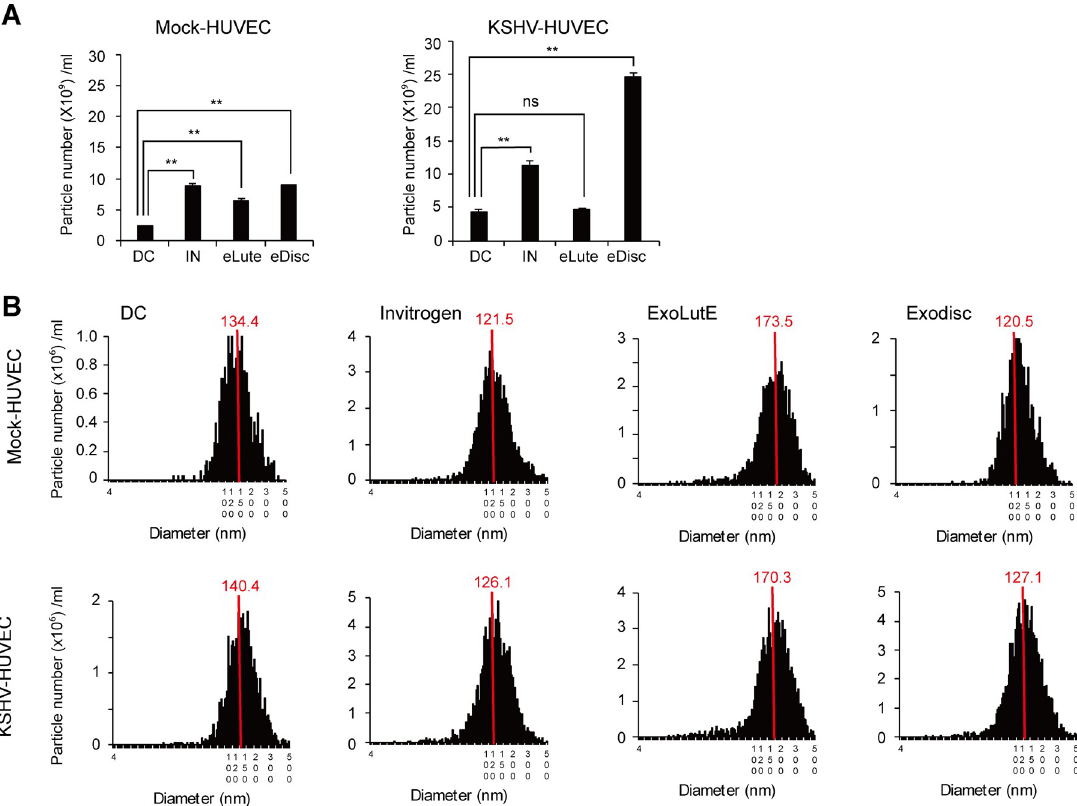
Fig 2. NTA of EVs separated by different methods. (A) The number of EV particles separated using each method. DC: EVs separated using differential centrifugation. Invitrogen: EVs separated using the Invitrogen Total Exosome Isolation reagent. eLutE: EVs separated using the ExoLutE exosome isolation kit. eDisc: EVs separated using Exodisc from LabSpinner. Data are shown as the mean ± SD, n = 3, � p < 0.05, �� p < 0.01, ns: not significant. (B) Size distribution of EVs separated using each method. The red line indicates the median value of all EV sizes. Mock-HUVEC: mock-infected HUVECs. KSHV-HUVEC: KSHV-infected